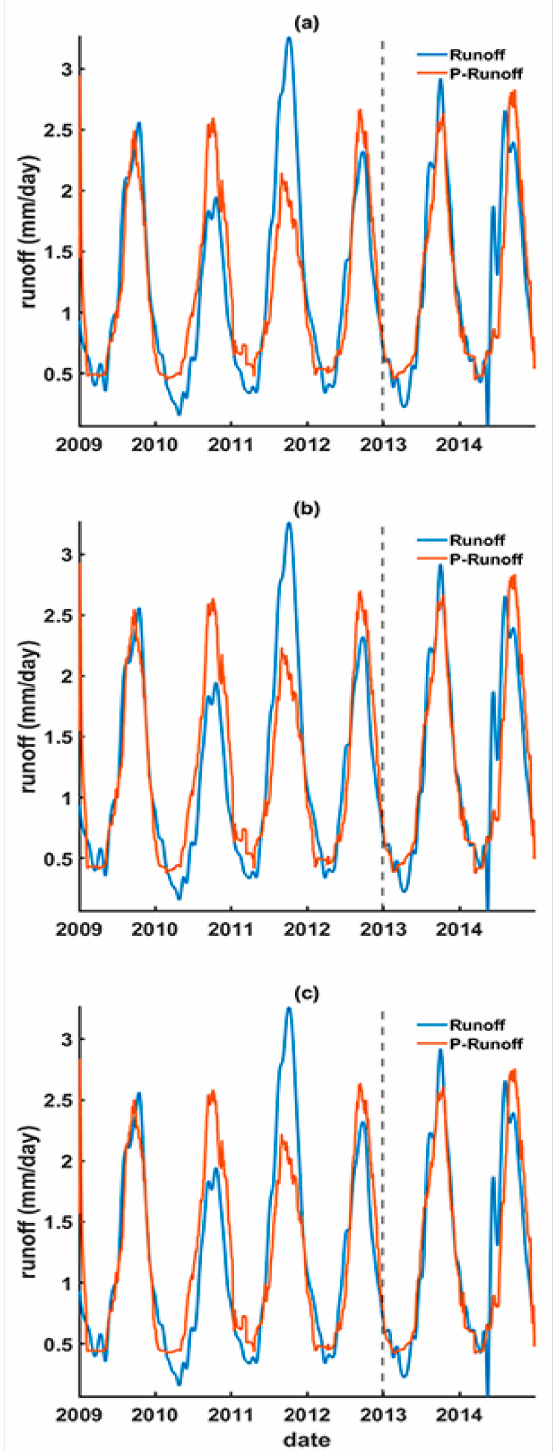
Figure 7. The reconstructed (during 2009–2012) and forecasted (during 2013–2014) runoff using the upstream TRMM precipitation (i.e., P-runoff) based on ( a ) linear regression, ( b ) ANN, and ( c ) LSTM